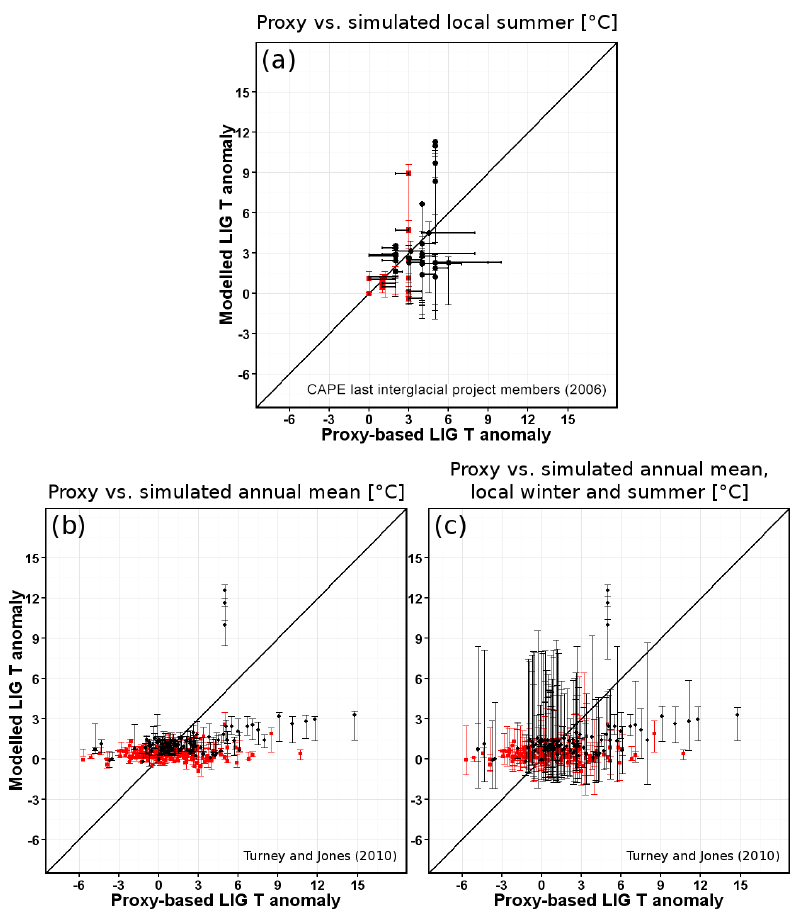
Figure 8. Effect of Greenland Ice Sheet elevation, insolation, albedo, and atmospheric methane concentration for the Last Interglacial (LIG) relative to pre-industrial (PI). (a) Proxy-based maximum LIG summer temperature anomalies relative to PI derived by CAPE-Last Interglacial Project Members (2006) plotted against simulated local summer surface temperature (TS) anomalies at 130kyrBP (LIG-1300m-alb) relative to PI at the location of the proxies. The horizontal bars represent the proxy-based temperature intervals derived by CAPE-Last Interglacial Project Members (2006). The vertical bars indicate the simulated TS anomalies at the maximum and minimum LIG TS with respect to local summer (i.e. the coldest and warmest 100 warmest months) derived from the time interval 130 to 120kyrBP (LIG-1300m-alb-tr) relative to PI, for each given proxy record location. (b) Proxy-based LIG annual mean temperature anomalies relative to present day (1961–1990) derived by Turney and Jones (2010), plotted against simulated annual mean TS anomalies at 130kyrBP (LIG-1300m-alb) relative to PI at the location of the proxies. The vertical bars indicate the simulated TS anomalies at the maximum and minimum LIG TS with respect to annual mean (i.e the coldest and warmest 100 model years) derived from the time interval 130 to 120kyrBP (LIG-1300m-alb-tr) relative to PI, for each given proxy record location. (c) Same as (b) but displaying vertical bars that represent local summer and local winter mean (i.e. the warmest 100 warmest months and coldest 100 coldest months). The squares (red) and circles (black) represent marine and terrestrial proxy-based temperature anomalies, respectively. The solid thick lines represent the 1:1 line, which indicates a perfect match of simulated and reconstructed